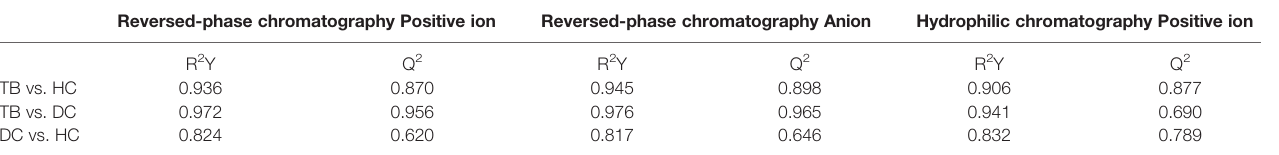
TABLE 2 | OPLS-DA models